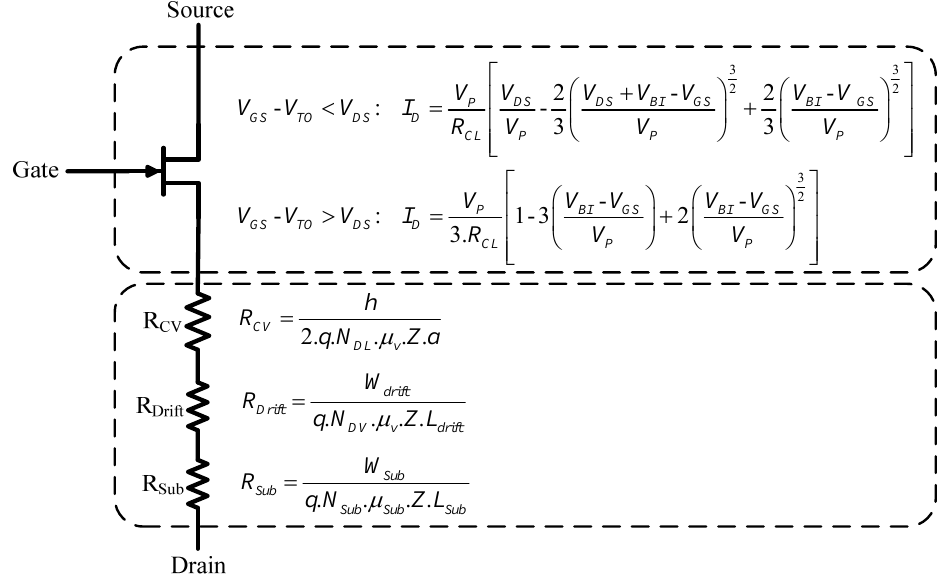
Figure 3. The two channels SiC-JFET circuit model.